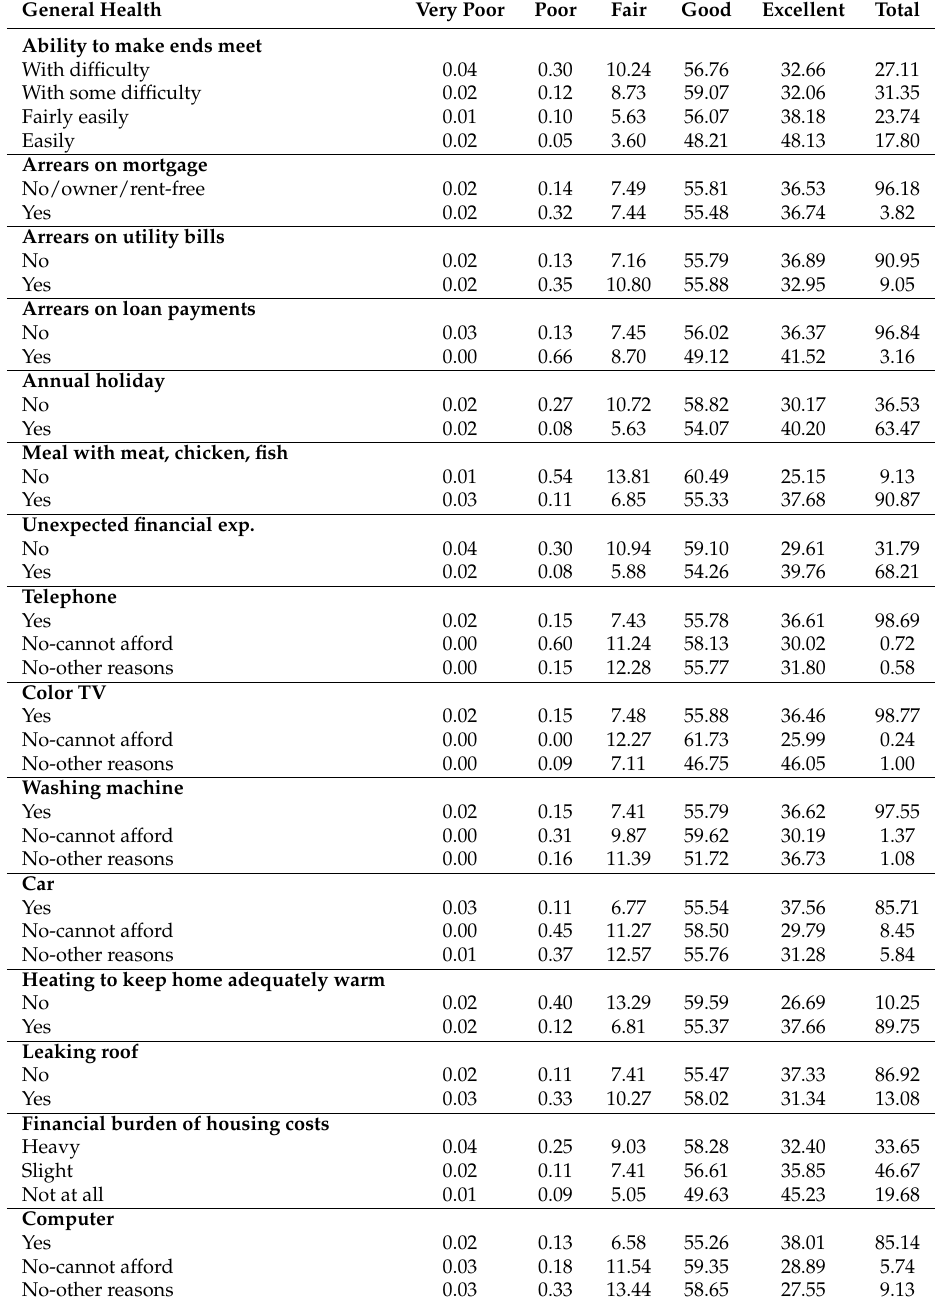
Table 2. Descriptive statistics for SHS (%) by economic deprivation